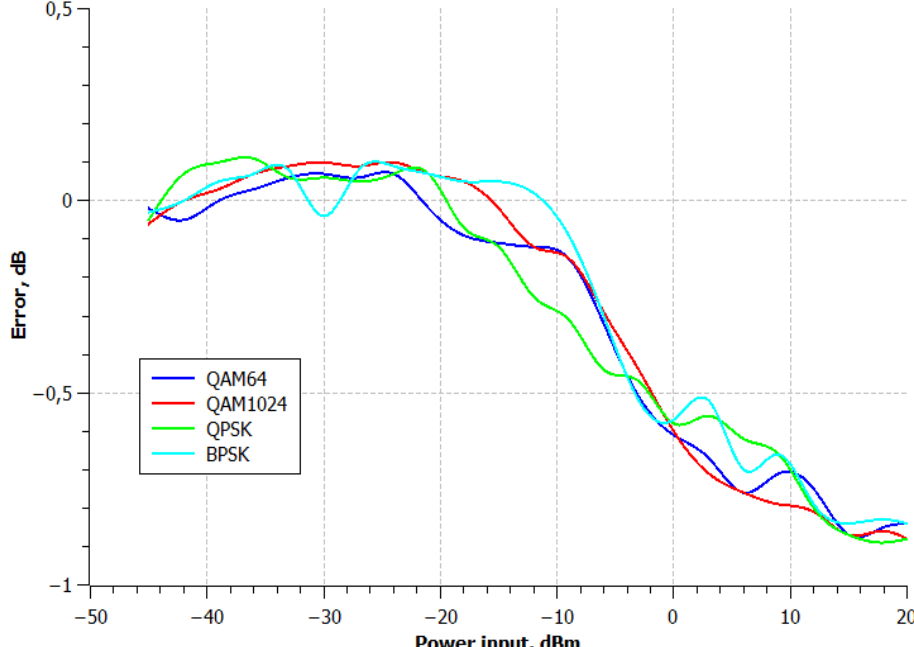
Fig. 9. The digital modulated signal measurements deviation error with NRPC and